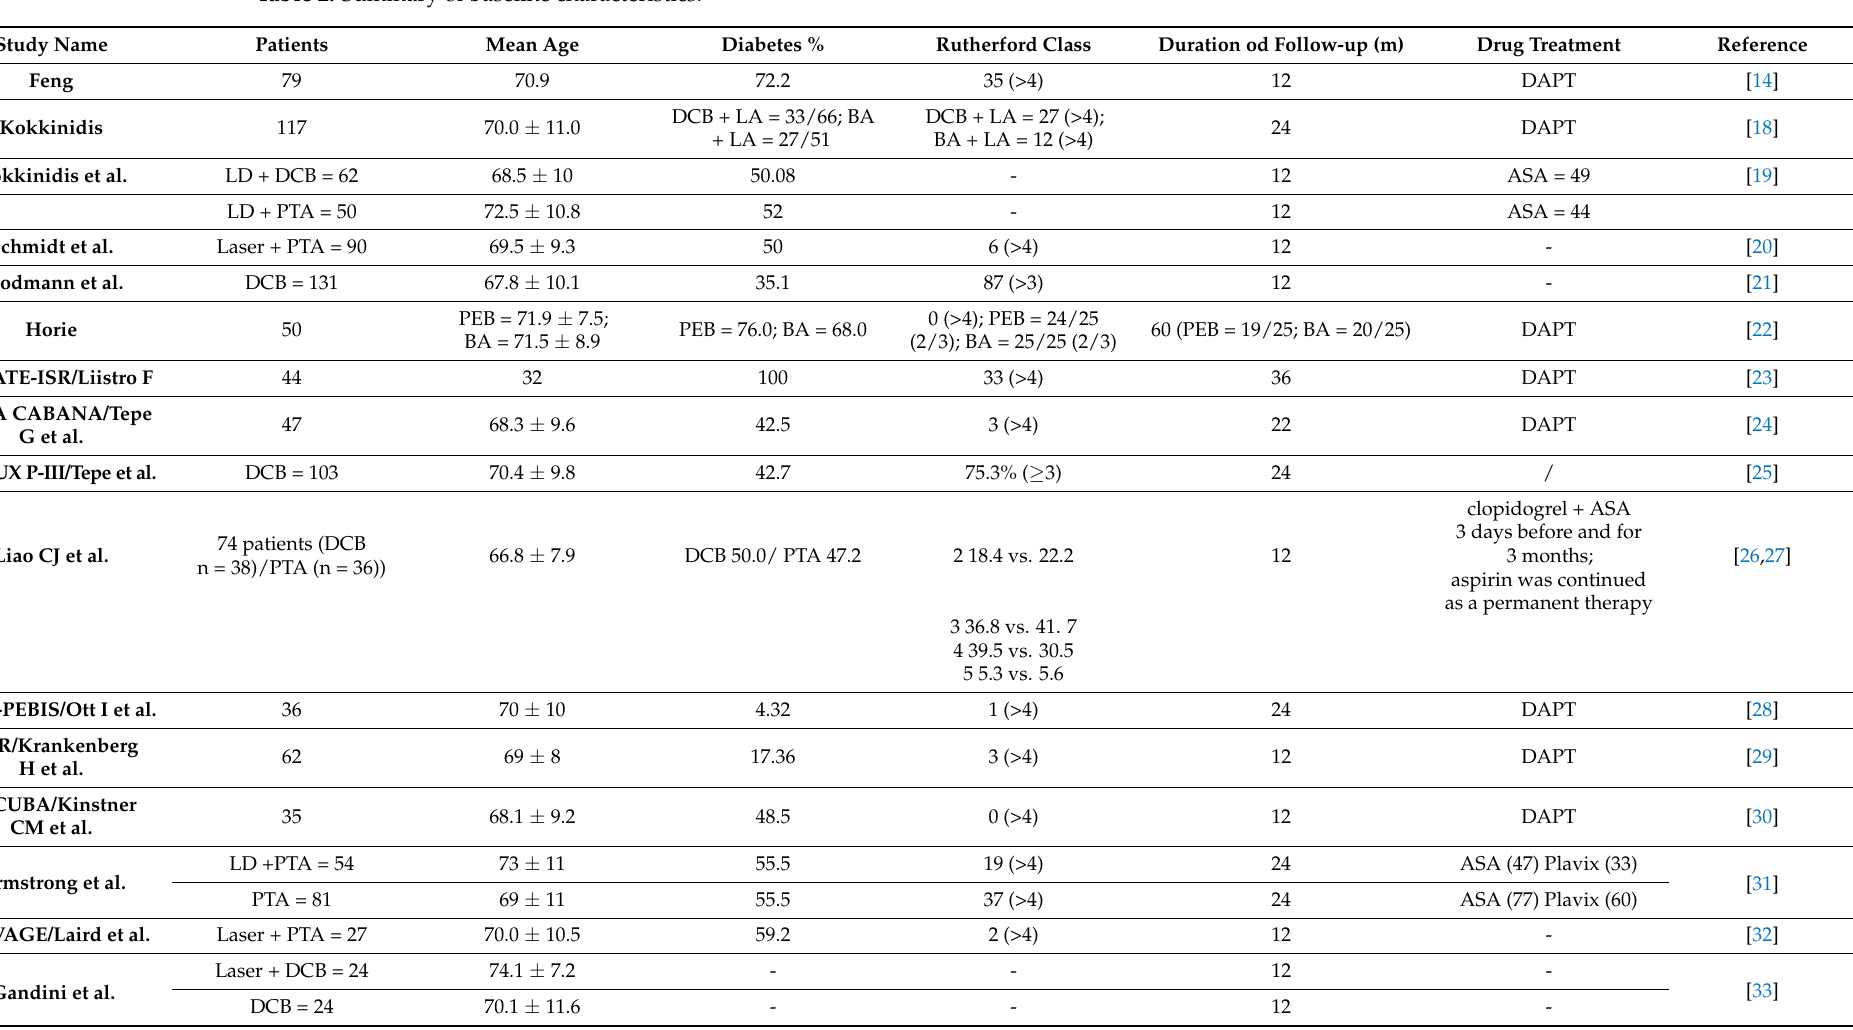
Table 2. Summary of baseline